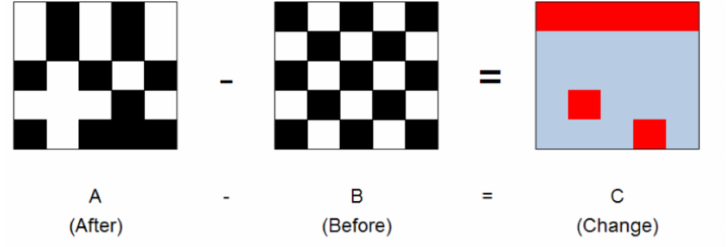
Figure 21. Example of difference mapping method used for a 2D 5 by 5 grid [73].